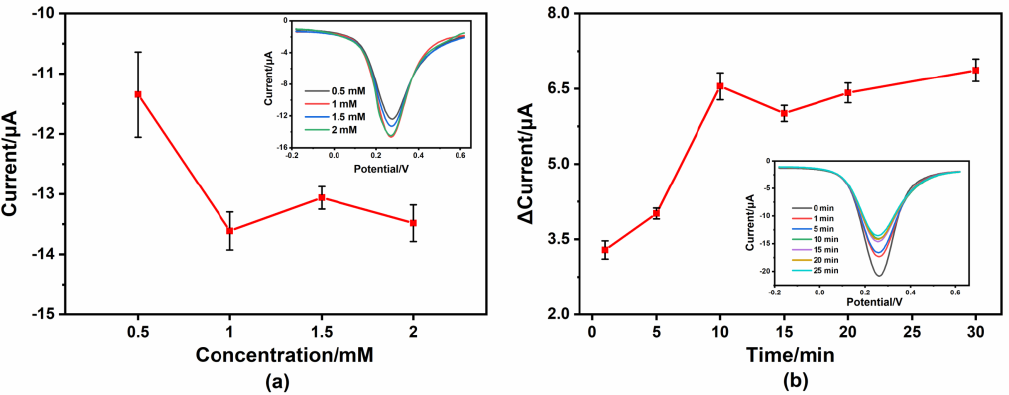
Figure 7. ( a ) The effect of 4-MPY concentration on the current response of the modified electrode by DPV measurement; ( b ) influence of reaction time on the detection of Hg 2+ (in 5 mM [Fe(CN) 6 ] 3 − /4 − with 10 μg/L Hg 2+ ).